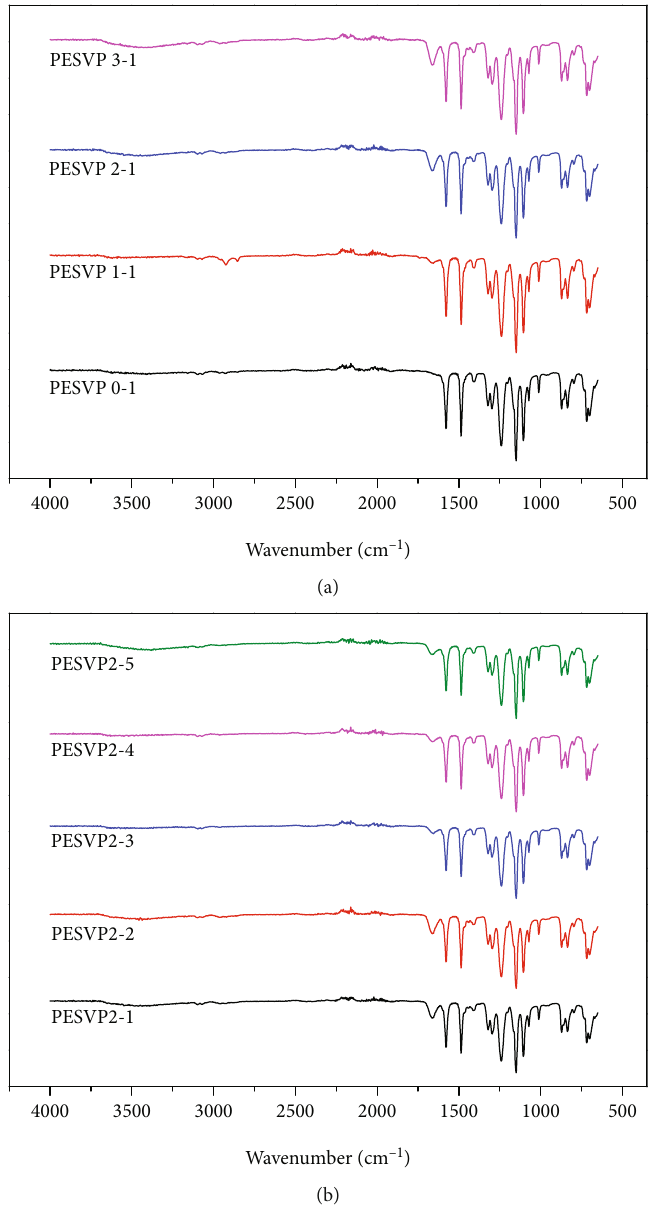
Figure 2: ATR-FTIR spectra of the di ff erent PESVP membranes: (a) e ff ect of PVP concentration; (b) e ff ect of nonsolvent